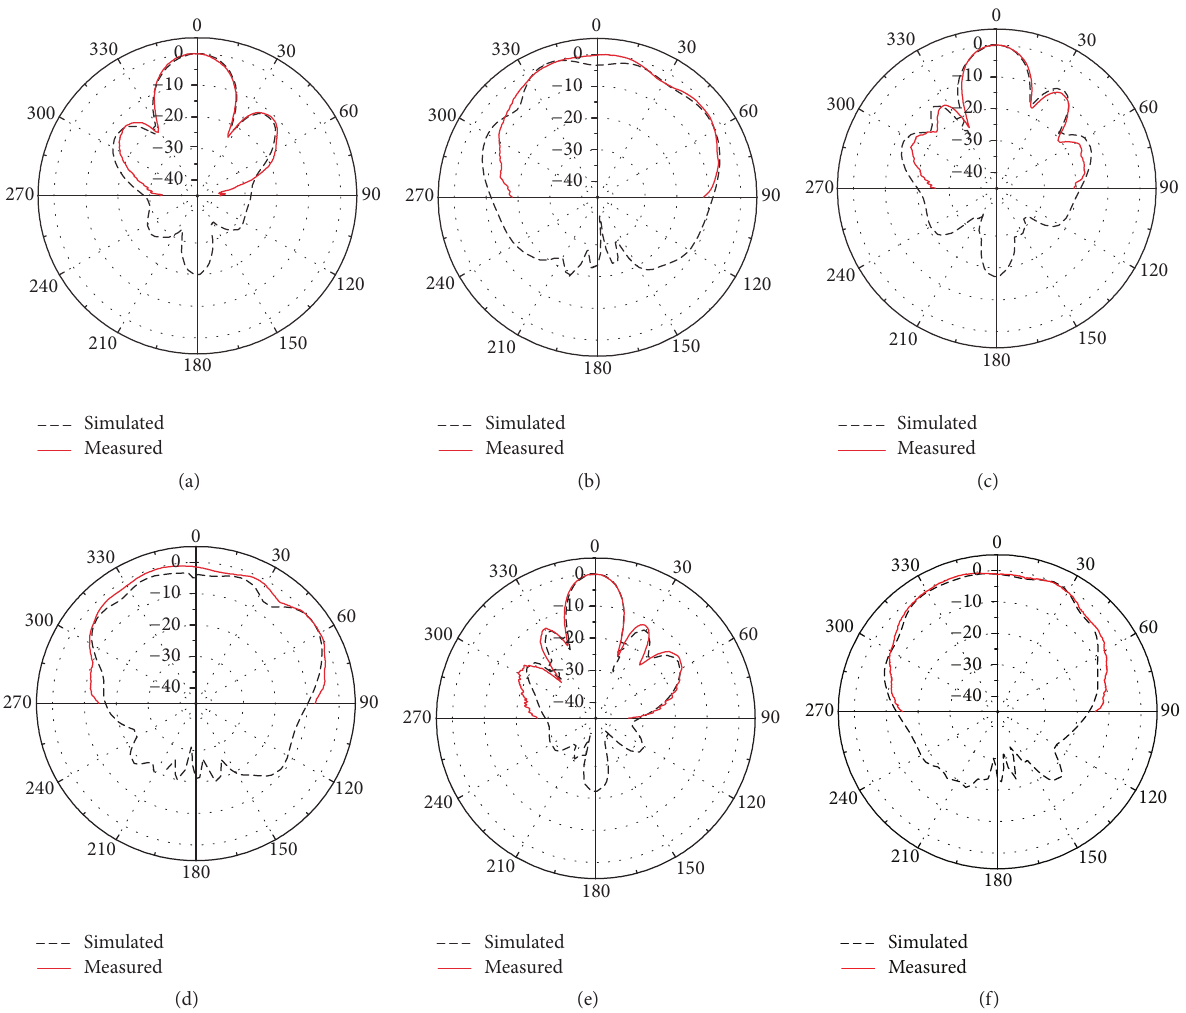
Figure 8: Simulated and measured radiation patterns of IMF-CBSA array in 𝑋𝑍 -plane ( 𝜑 = 0 ∘ ) and 𝑌𝑍 -plane ( 𝜑 = 90 ∘ ): (a) 18GHz in 𝑋𝑍 -plane; (b) 18 GHz in 𝑌𝑍 -plane; (c) 22 GHz in 𝑋𝑍 -plane; (d) 22 GHz in 𝑌𝑍 -plane; (e) 26 GHz in 𝑋𝑍 -plane; (f) 26 GHz in 𝑌𝑍 -plane.